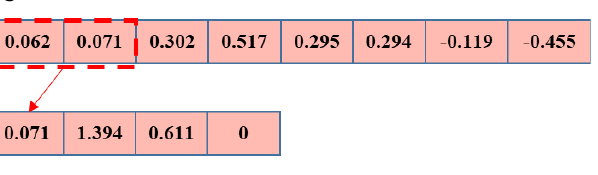
Fig. 3. Max-Pooling Operation